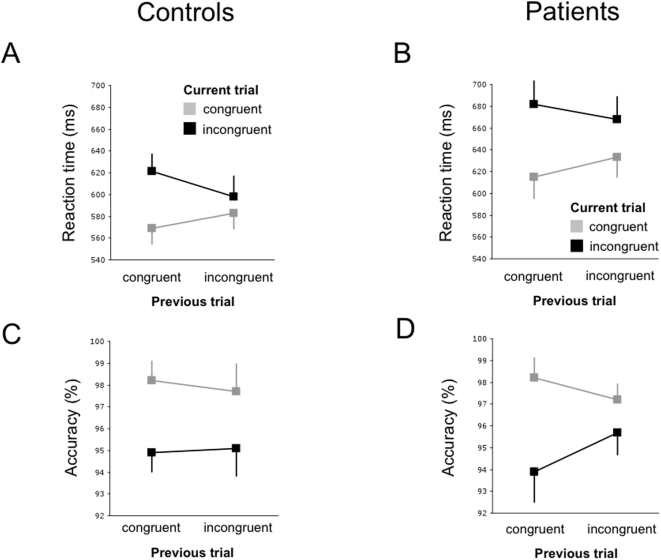
Conflict adaptation effects in controls and patients. Note generally slower RTs in patients. Labels on x-axes refer to the current trial. (A) For reaction times a significant previous×congruence interaction was found for both groups (controls: F = 13.760, p = 0.0002; patients: F = 8.104, p = 0.0045). (B) For accuracy rates an effect of congruence of the current trial (controls: F = 14.280, p = 0.003; patients: F = 7.328, p = 0.085) was found, but no effect of previous trial type or the previous×congruence interaction.